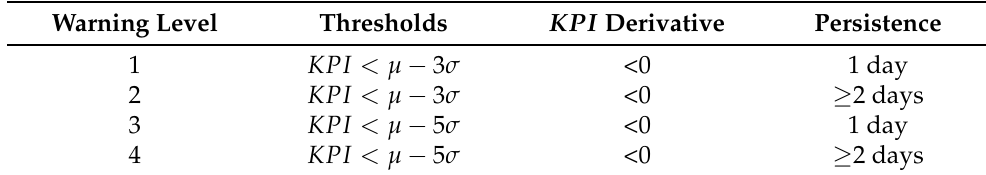
Table 4. Logic for the generation of the warning